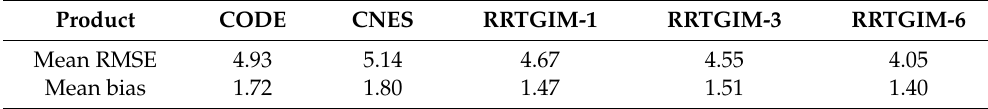
Table 5. Mean RMSE and mean bias of VTEC products (unit: TECU).